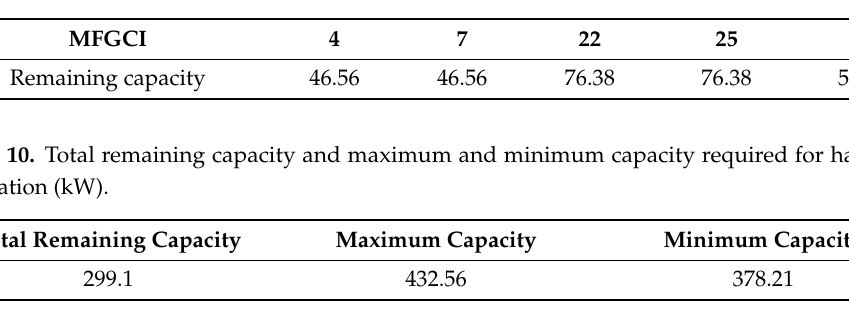
Table 11. Capacity of each MFGCI involved in harmonic mitigation